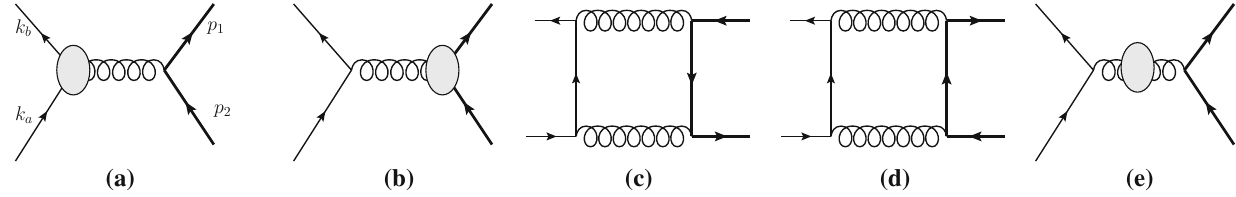
legs is not shown but included in the calculation. Thick lines represent heavy